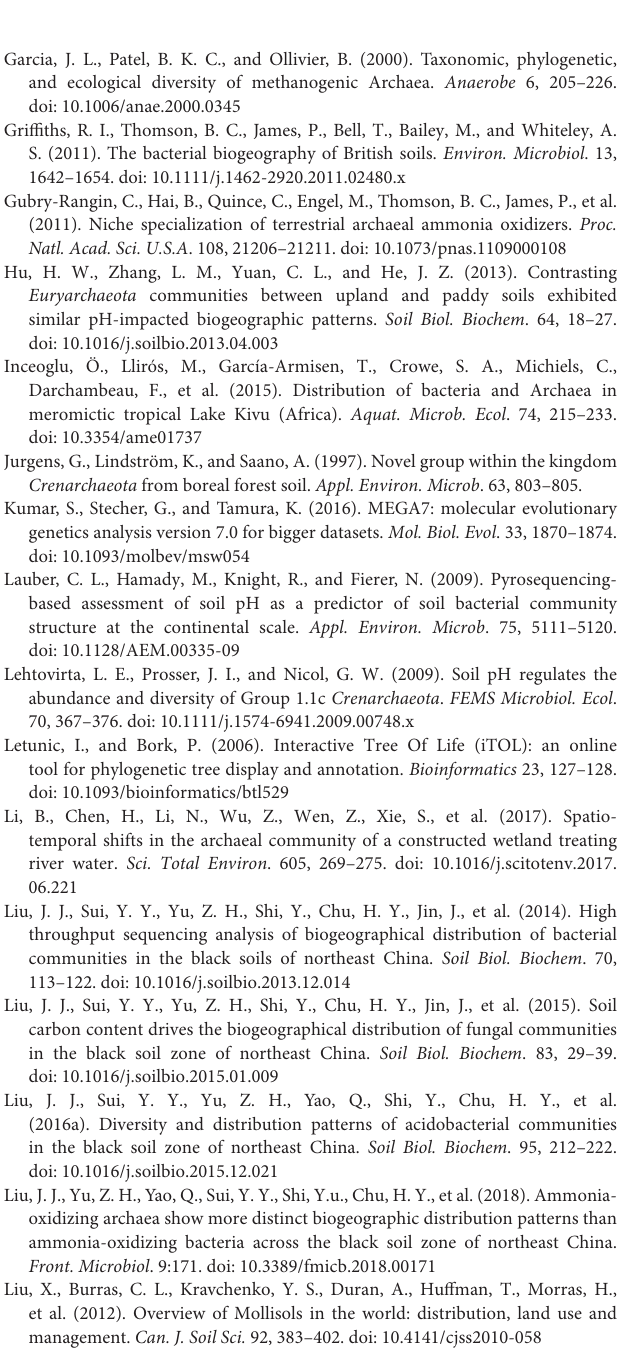
Figure S3 | Neighbor-joining tree showing the phylogenetic positions of Thaumarchaeota OTUs observed in the black soils. The numbers in the parentheses after individual OTUs indicate the observed number of reads, the numbers in the parentheses of reference clones, or isolates indicate the accession numbers in the NCBI website. Bootstrap values < 50 are not shown. The scale bar represents 0.05 substitutions per nucleotide. Table S1 | Location, physicochemical properties, abundance, OTU richness and phylogenetic diversity of archaeal community in 26 black soils for this study.